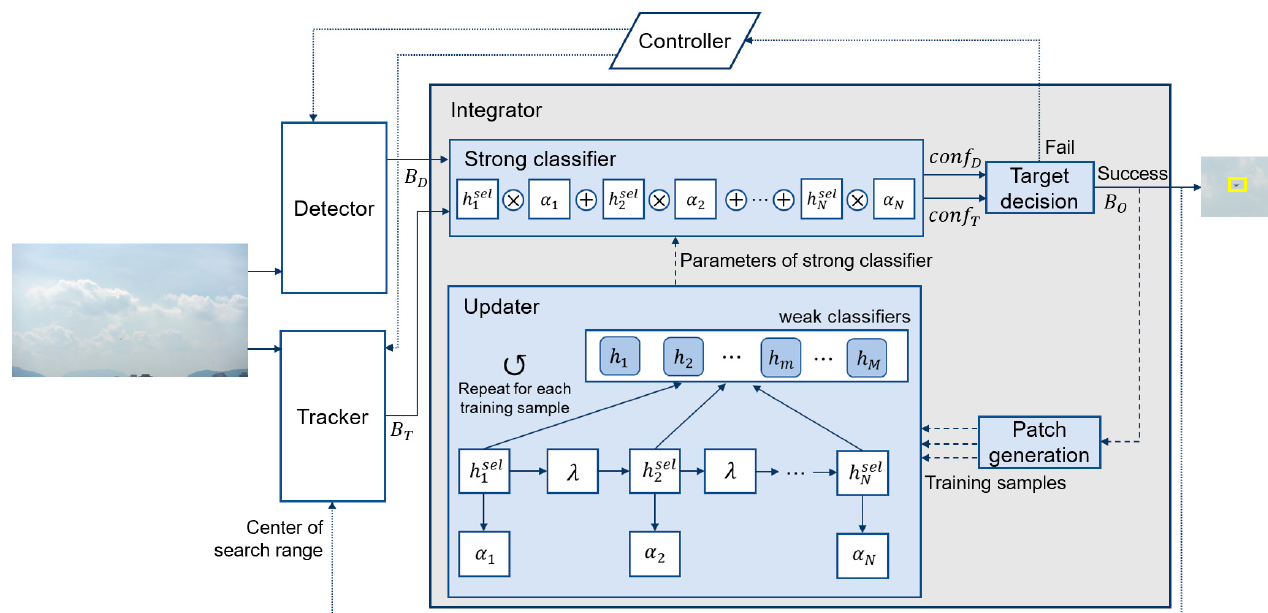
Figure 1. Framework of the proposed hybrid tracking method.